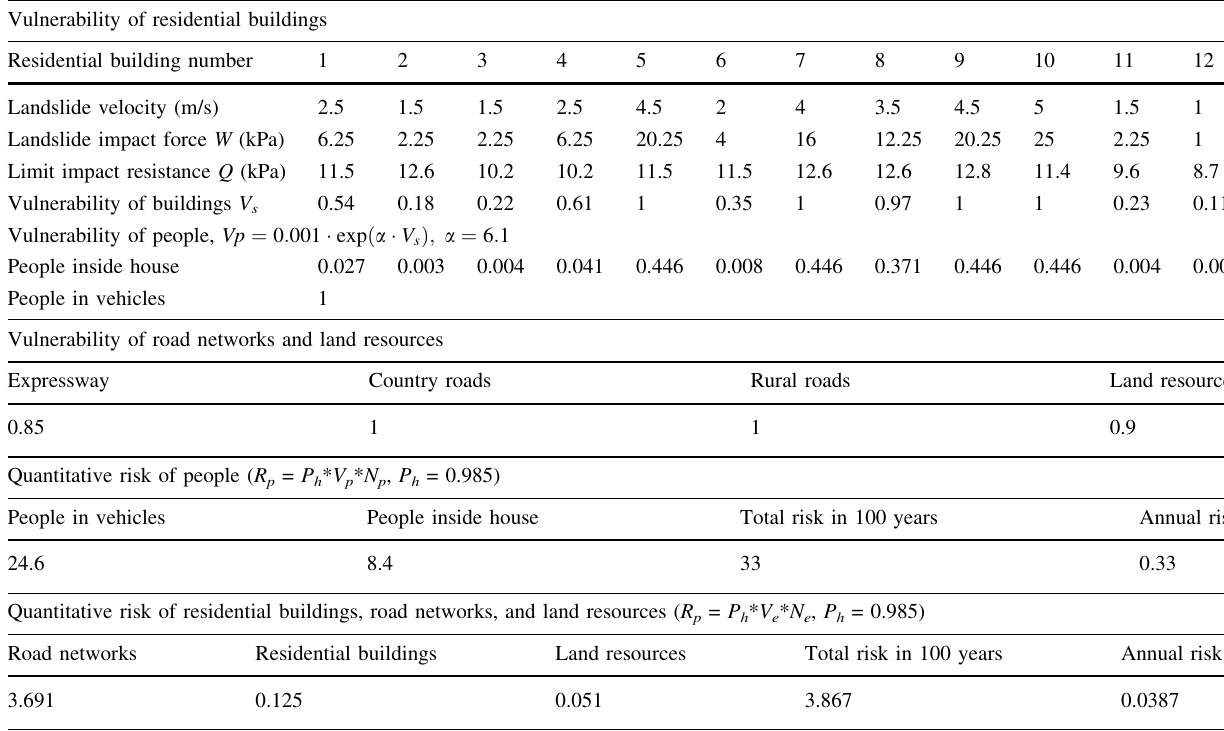
Table 4 Results of vulnerability and risk assessment of elements at risk (unit of value: million USD) in the 2013 Sunjia landslide in Wanzhou County Vulnerability of residential